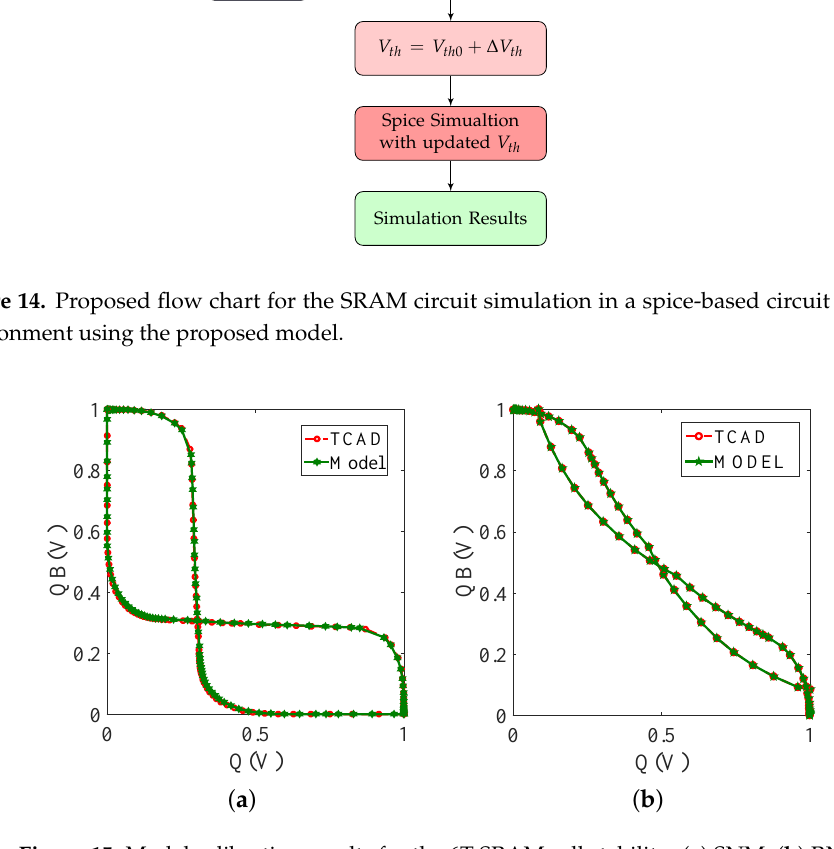
Figure 15. Model calibration results for the 6T SRAM cell stability: ( a ) SNM; ( b )